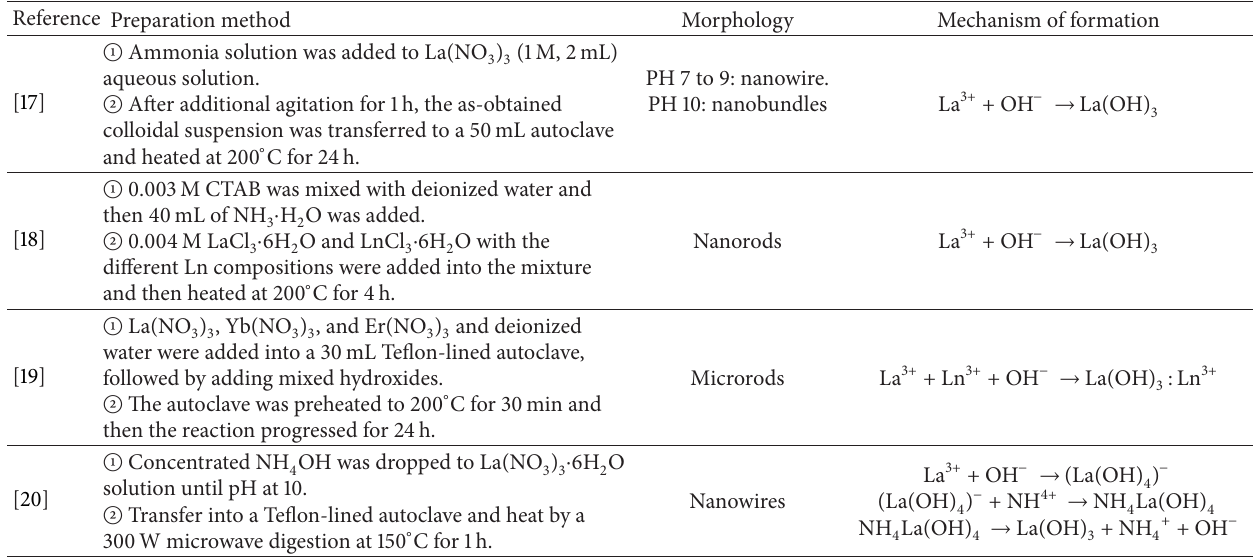
nanostructure by hydrothermal 3